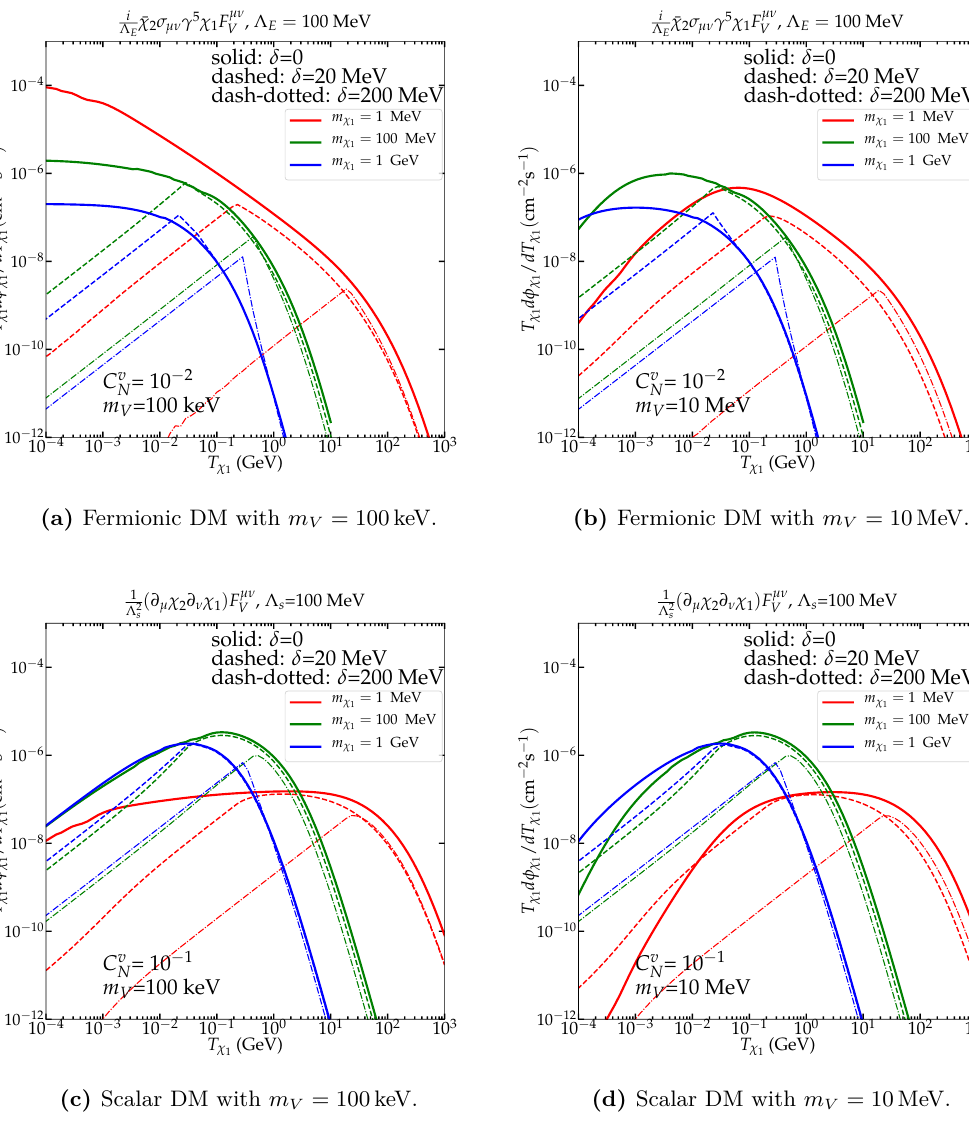
(upper panels) and L s (lower panels). The mediator 2 2 = 100 keV (left figures) and m = 10 MeV (right figures). The color V V